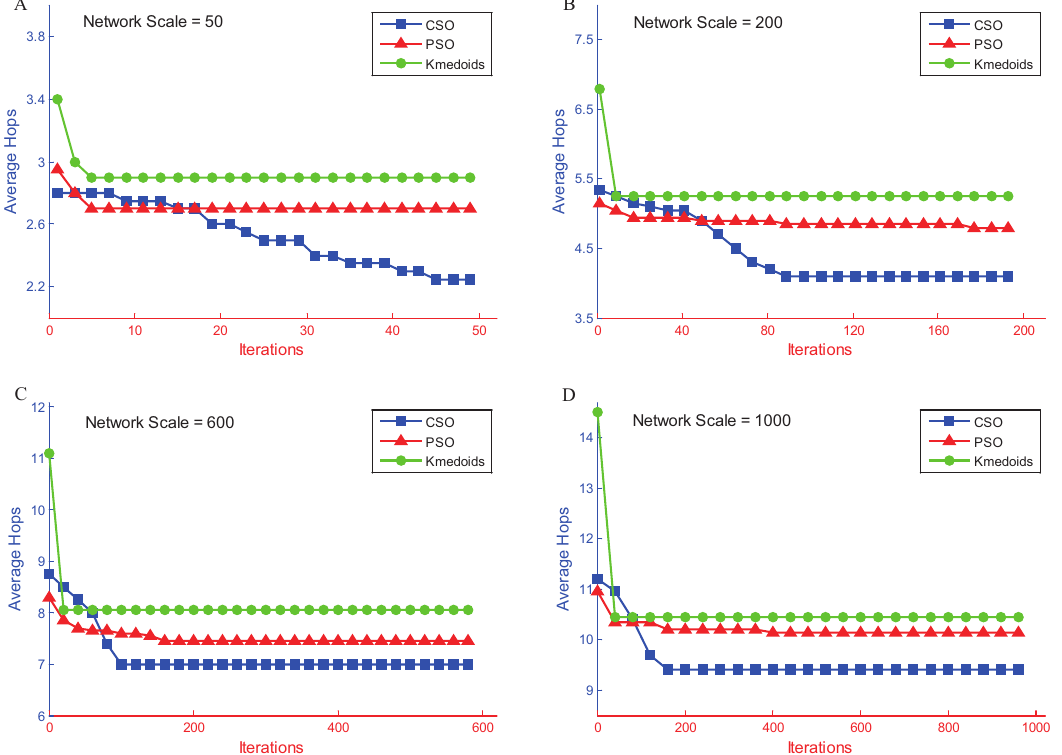
Figure 6. Convergence of three algorithms at different network scales. ( A ) 50 nodes; ( B ) 200 nodes; ( C ) 600 nodes; ( D ) 1000